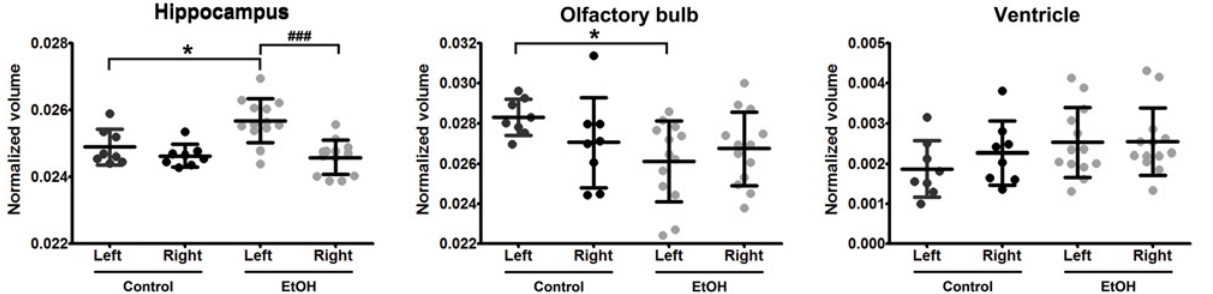
Fig 7. Altered volumes of left and right hippocampi, olfactory bulbs, and lateral ventricles of ethanol-exposed offspring. Wilcoxon test was used to access left-right differences within the same animals (#) and Mann-Whitney test to compare control and ethanol-exposed (EtOH) mice ( * ). # / * p < 0.05 and ### p < 0.001. Each dot represents an individual adult male mouse (P60). Control mice are illustrated in black and ethanol-exposed offspring in grey. Bars are averaged values ±